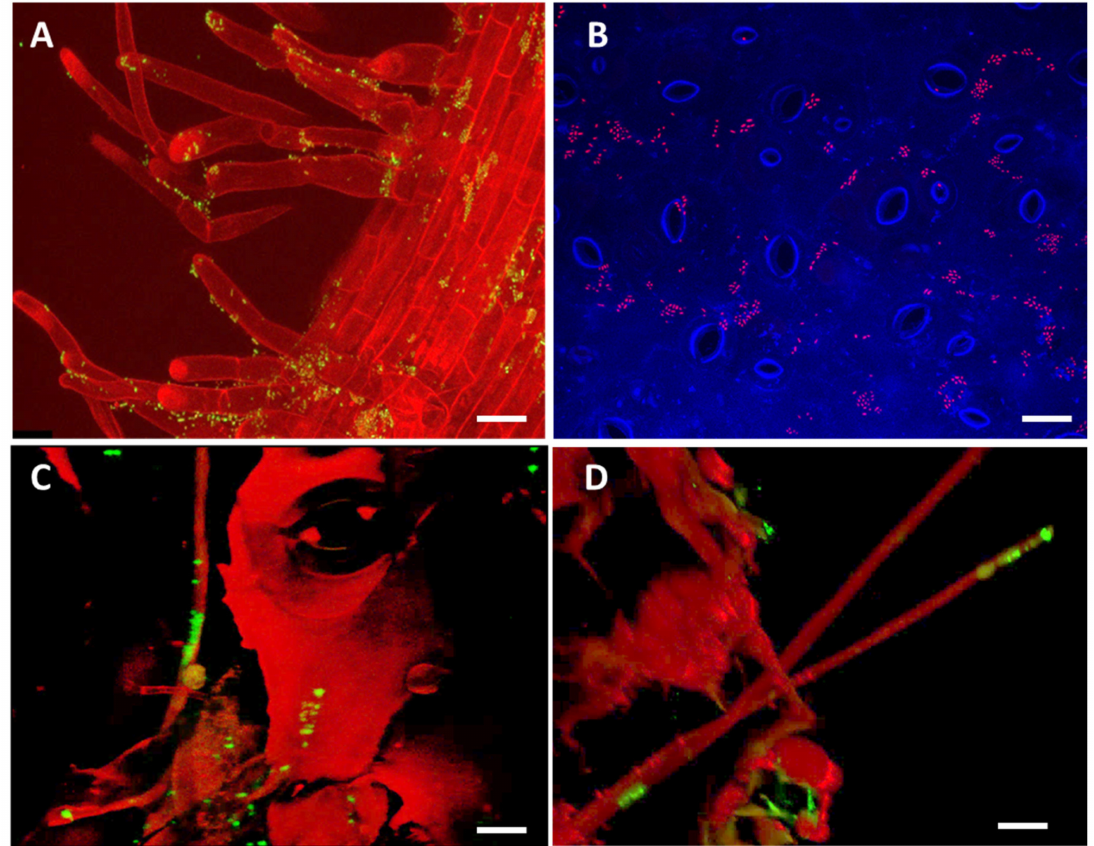
Figure 3. Visualization of a three-way interaction between the host plant, antagonistic bacterium and a pathogenic fungus. The CLSM images show the 28-day old oilseed rape seedlings whose seeds were bioprimed with gfp -labelled S. plymuthica HRO-C48—visible as green or red dots ( A , B ). For the images ( C , D ), the seedlings were additionally infected with V. longisporum. In ( C , D ), the BacLight LIVE / DEAD stain was used to visualize alive (green) and dead (red) bacterial cells. Bar represents 25 µ